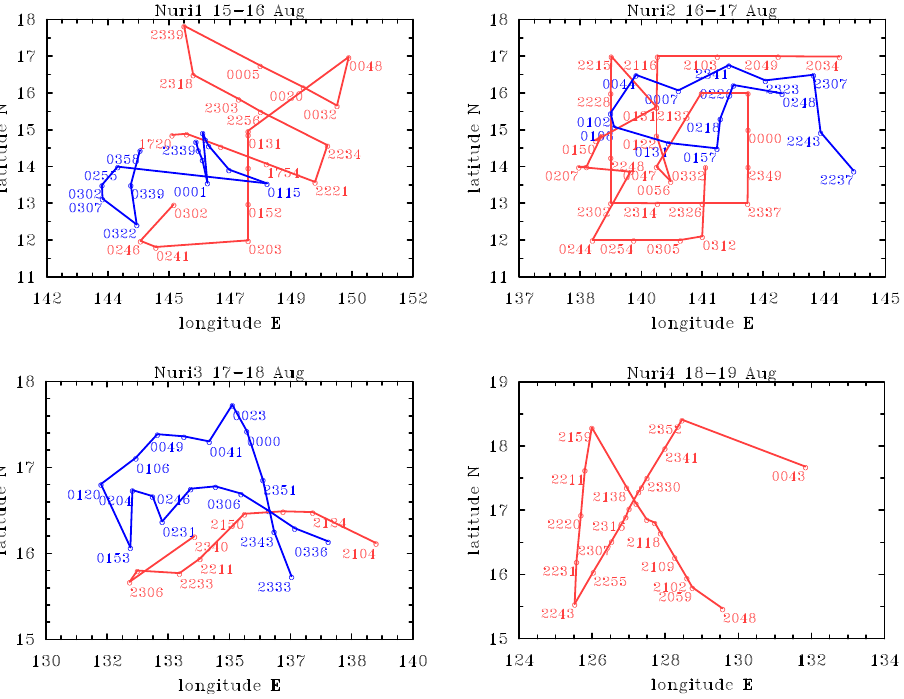
Fig. 1. Drop points and times of drops for (a) Nuri1, (b) Nuri2, (c) Nuri3, and (d) Nuri4. The aircraft track is marked with the location of soundings along the track (small circles). Red denotes the C130 aircraft while blue denotes the NRL P3 aircraft. See text for further details. and Nuri2 were from about 10 km. The sondes released from the C130 for Nuri3 were from an altitude of about 7.5